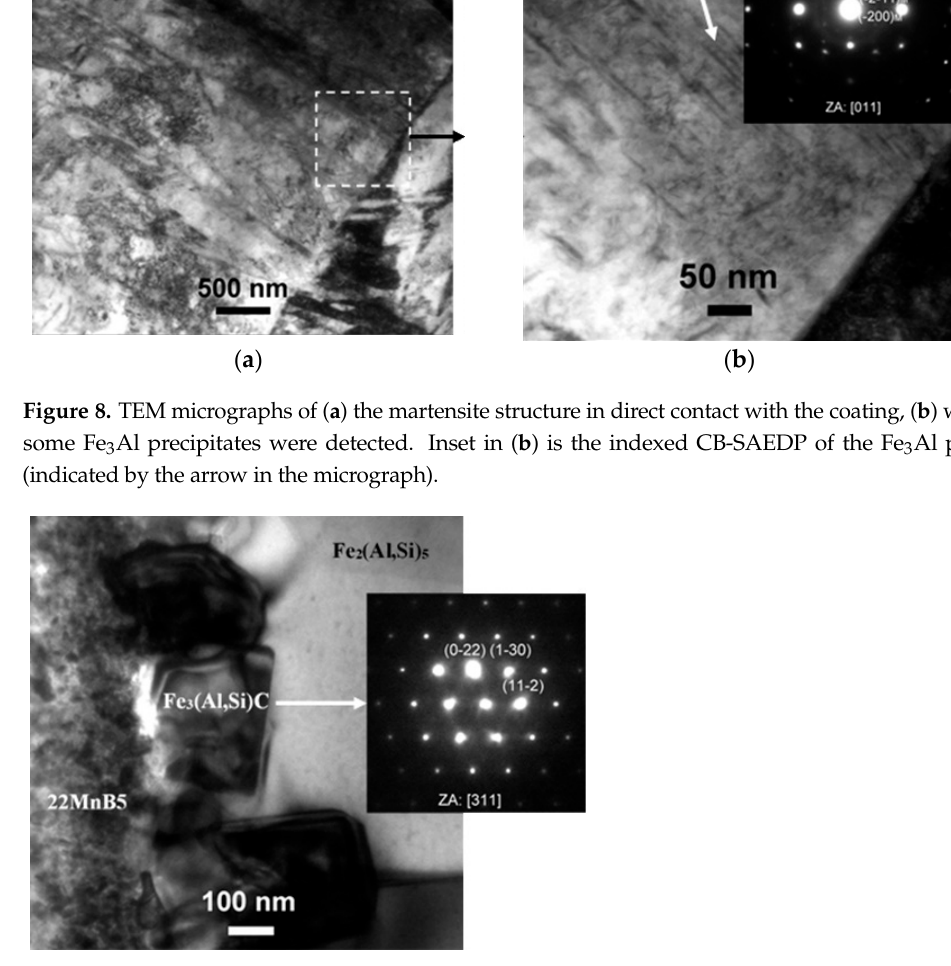
Figure 9. TEM micrograph of the first coating sublayer directly in contact with the martensite structure of the hardened 22MnB5 steel. Inset is the indexed CB-SAEDP, revealing the crystallographic nature of this thin sublayer identified as Fe 3 (Al,Si)C.